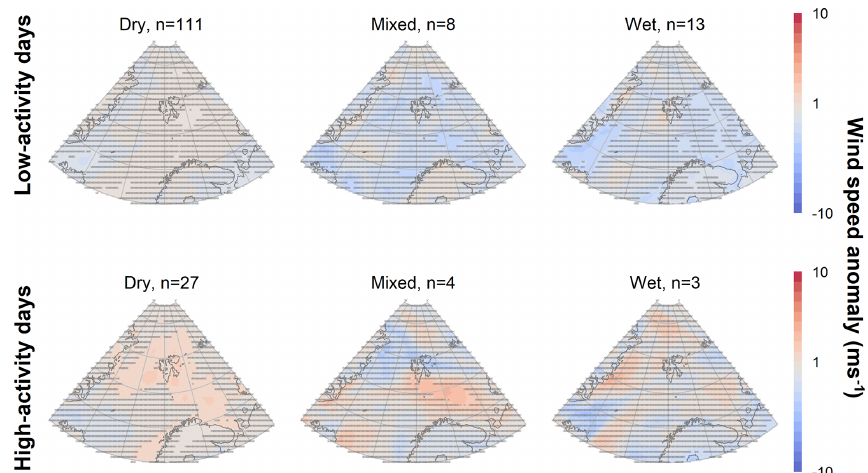
Figure C3. Daily mean wind speed anomalies, relative to mean winter conditions (Fig. B3), for dry, mixed, and wet avalanche low- and high-activity days. Anomalies that are not significantly statistically different from mean winter conditions are indicated with dense